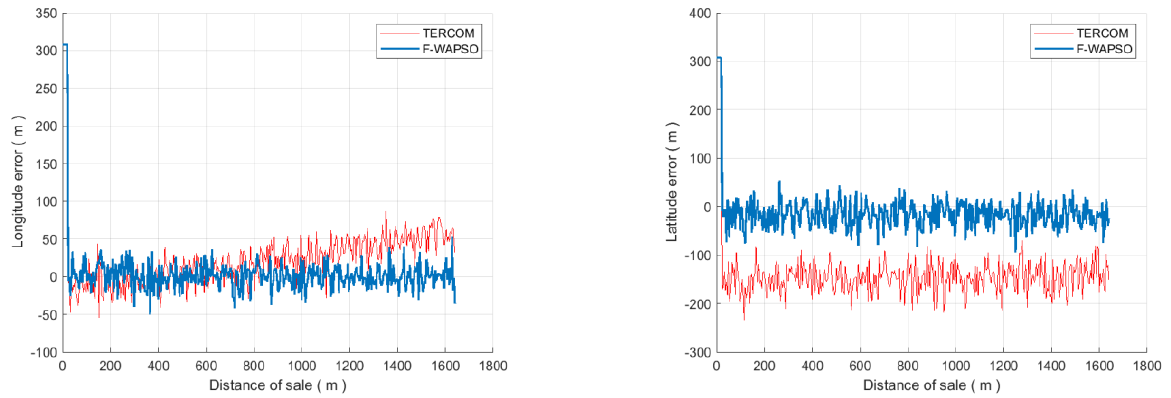
Figure 5. Longitude and latitude error curves of trajectory A.